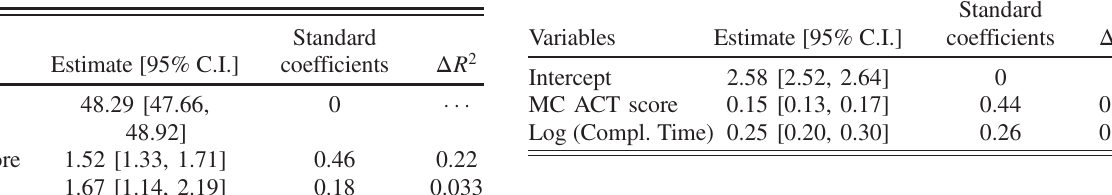
TABLE IV. Results of model 2 predicting the exam component of a student ’ s grade, ranging from 0-70 (percent), with the student ’ s (mean-centered) ACT score and the log of their average completion time as the independent variables. The estimates of the coefficients are presented with 95% confidence intervals. The Δ R 2 column corresponds to the increase in R 2 as the model was forward stepped.